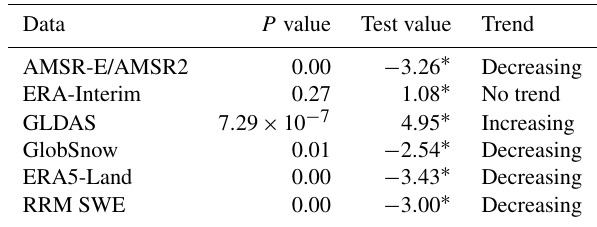
Table 4. Results of the Mann–Kendall trend test performed for var- ious snow water equivalent products from 1979 to